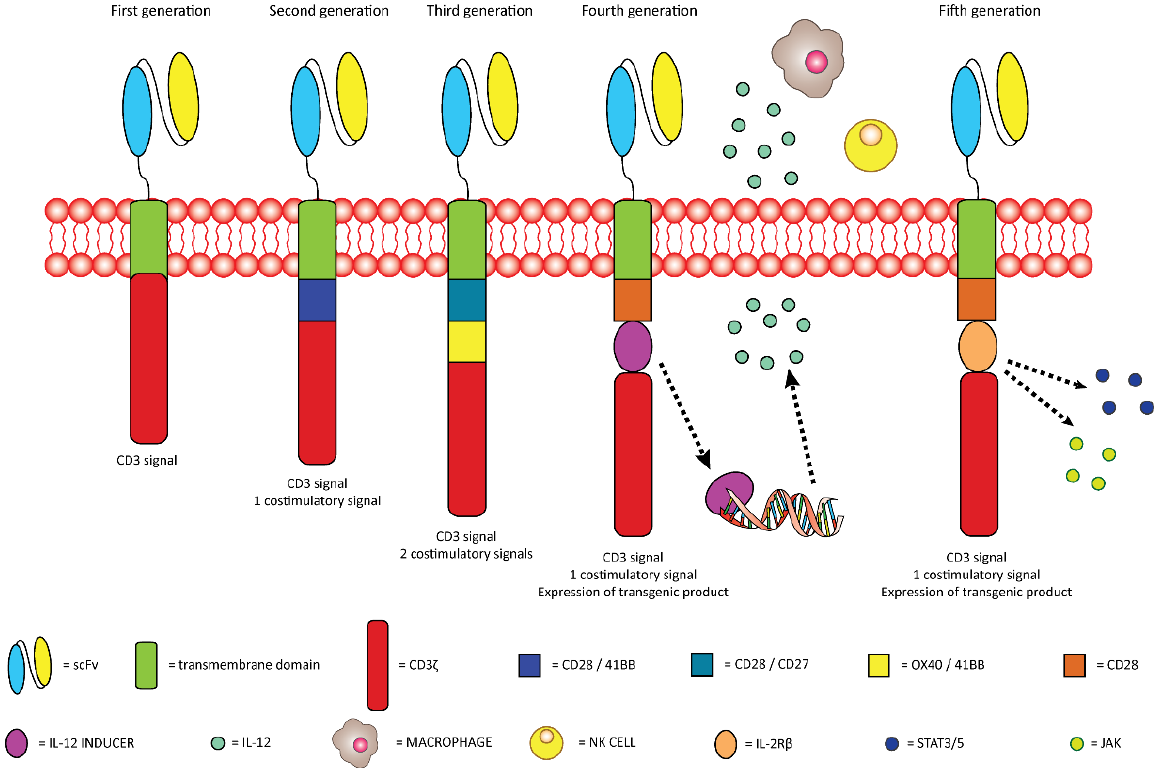
Figure 4. Schematic representation of the five generations of CAR-T cells.